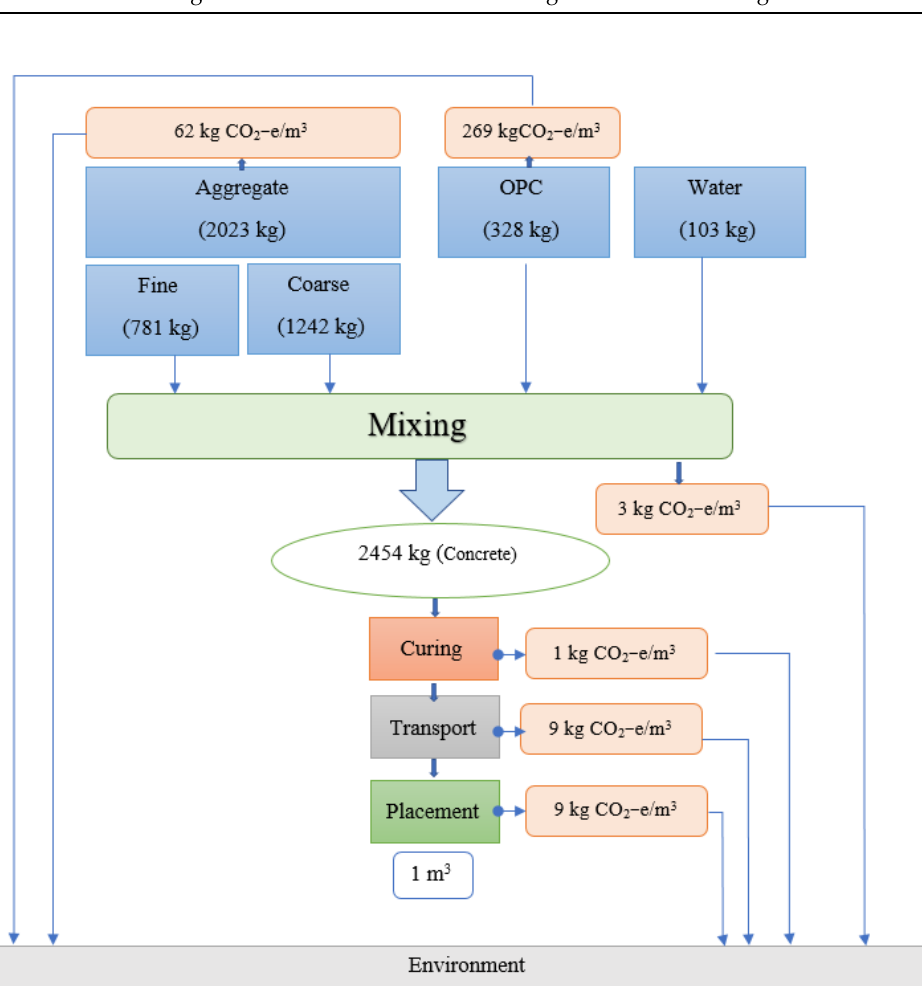
Figure 7. Life cycle stages for OPC concrete.